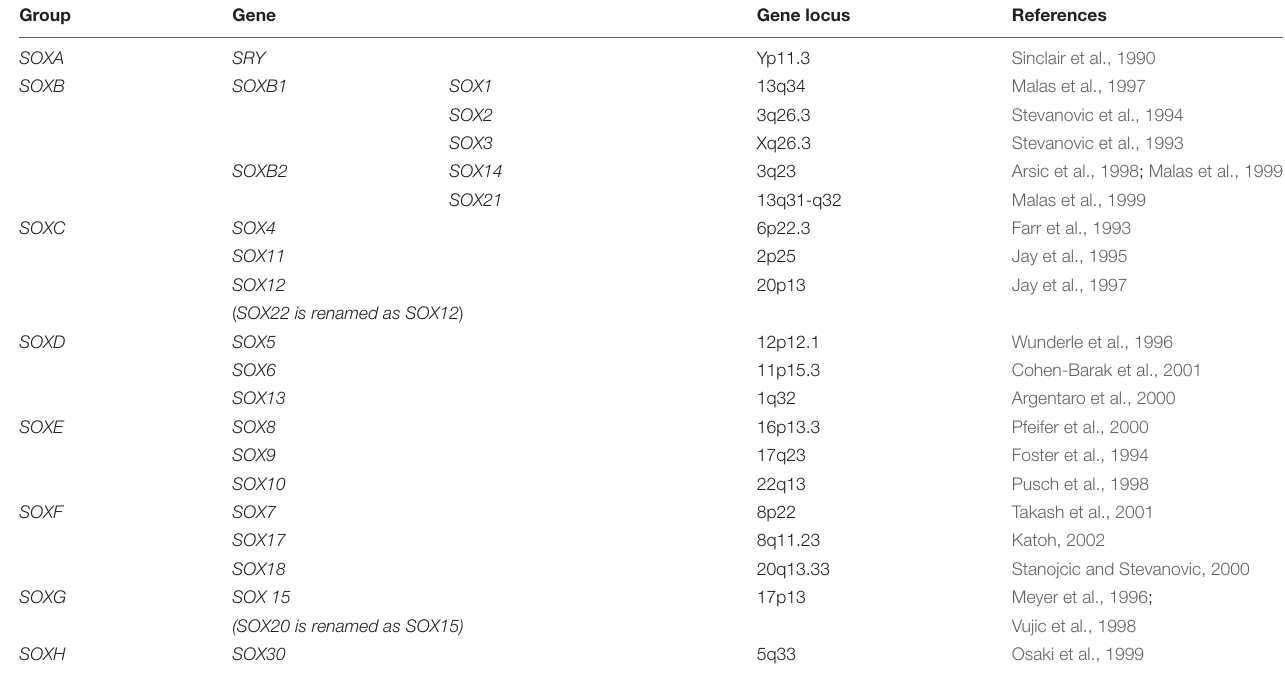
TABLE 1 | Classification of the human SOX